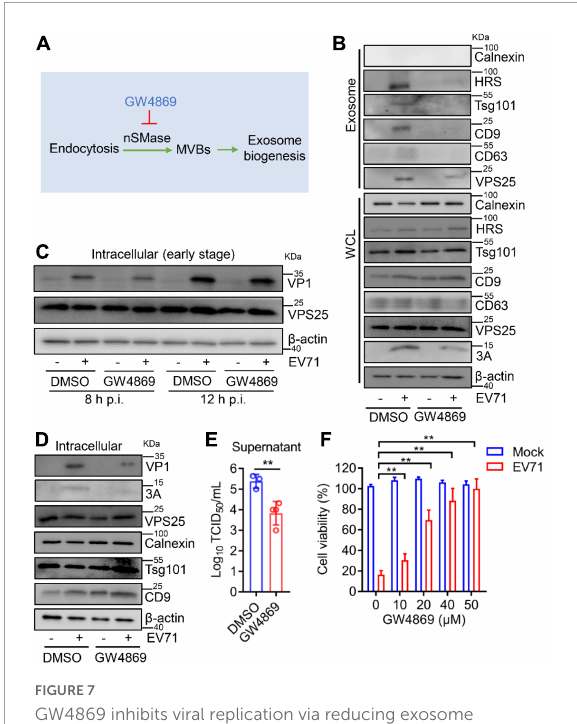
FIGURE7 GW4869 inhibits viral replication via reducing exosome biogenesis. (A) GW4869 acts as an exosome inhibitor in the endocytic pathway. (B–F) RD cells were incubated with GW4869 (20 µ M) for 2 h and then infected with EV71 (MOI = 0.5). At 24 h p.i., the extracted exosomes and cell lysates were analyzed by Western blot (B) . At 8 and 12 h p.i., the cell lysates were analyzed by Western blot (C) . At 24 h p.i., cell lysates were analyzed